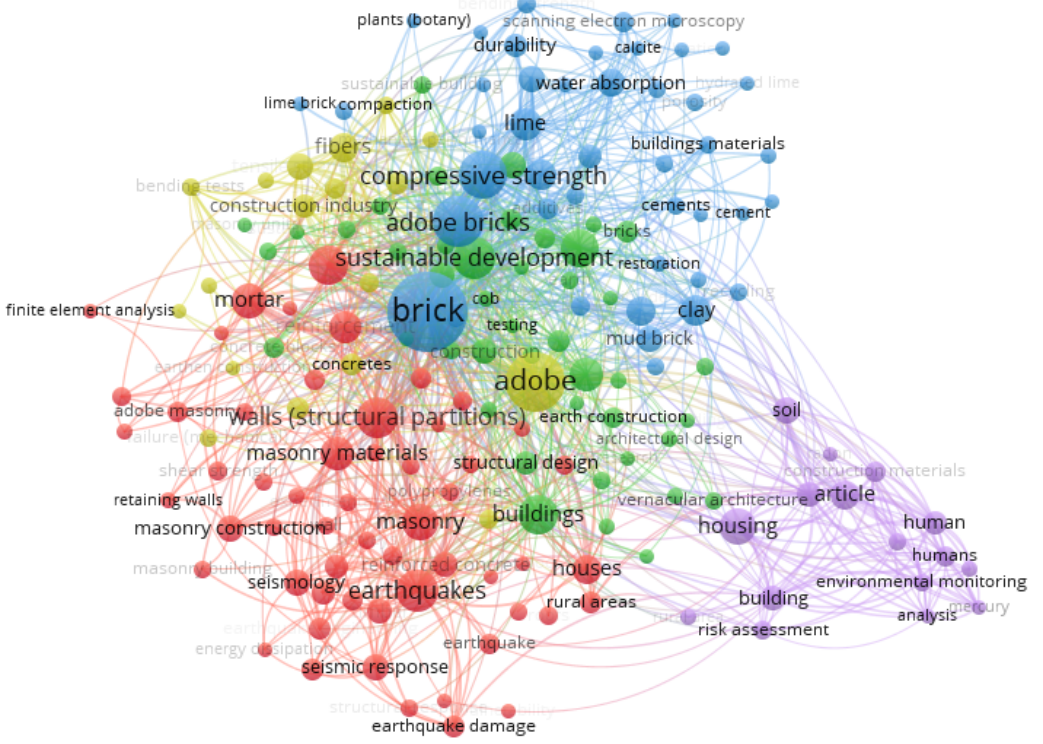
Figure 1. Bibliometric analysis of adobe blocks in the Scopus database.